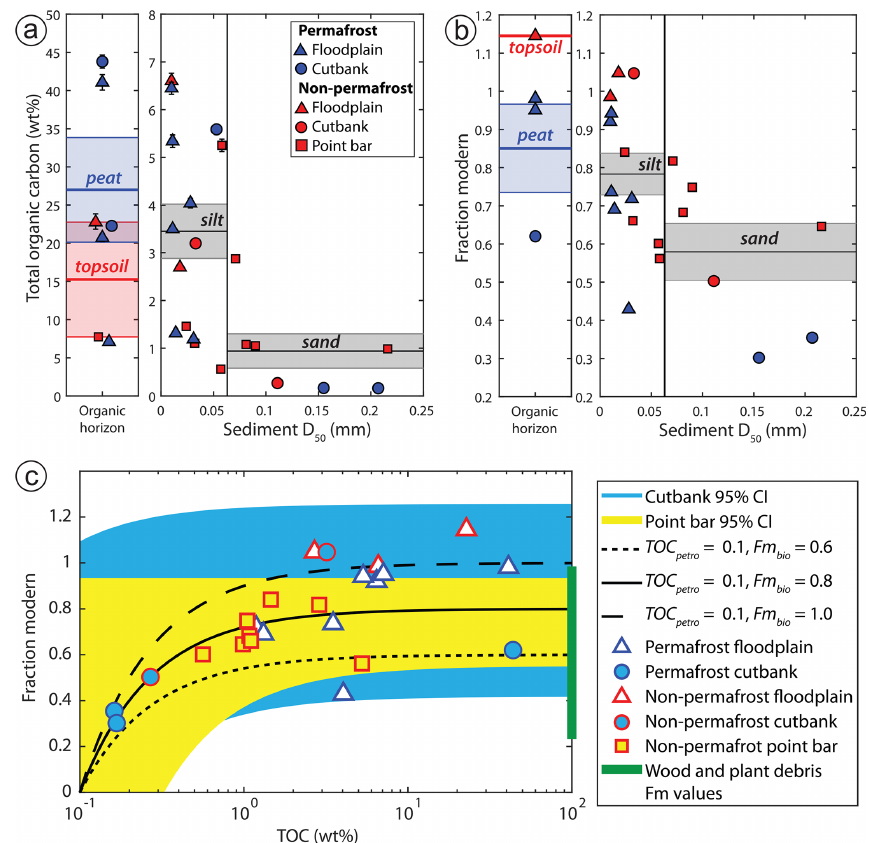
Figure 4. Floodplain sediment geochemistry results. (a) Total organic carbon versus median sediment grain size, with organic horizons split into ice-rich permafrost peat and non-permafrost topsoil, with 1SD error bars. The horizontal lines indicate the mean and shaded region the standard error of the mean for the peat ( n = 5, blue shading), topsoil ( n = 2, red shading), silt ( D 50 < 0 . 63mm, n = 14, gray shading), and sand ( D 50 > 0 . 63mm, n = 7, gray shading) grain size classes. (b) Radiocarbon activity (reported as fraction modern, Fm) versus median grain size, with 1SD error bars and shaded regions indicating the mean and standard error of the mean for peat ( n = 3), topsoil ( n = 1), silt ( n = 13), and sand ( n = 7). (c) Sediment sample fraction modern (Fm meas ) plotted against TOC content (TOC meas ) and fit using Eq. (4) to calculate end-members for biospheric radiocarbon fraction modern (Fm bio ) and petrogenic organic carbon content (TOC petro ). The 95% confidence intervals (CI) for cutbanks and point bars are shaded in blue and yellow, with the horizontal upper bound on the point bar CI representing TOC petro = 0 . 0wt%. Black lines denote mixing between representative values of TOC petro and Fm bio . The range of wood and plant debris Fm values is plotted on the right y axis, indicating the likely range of biospheric